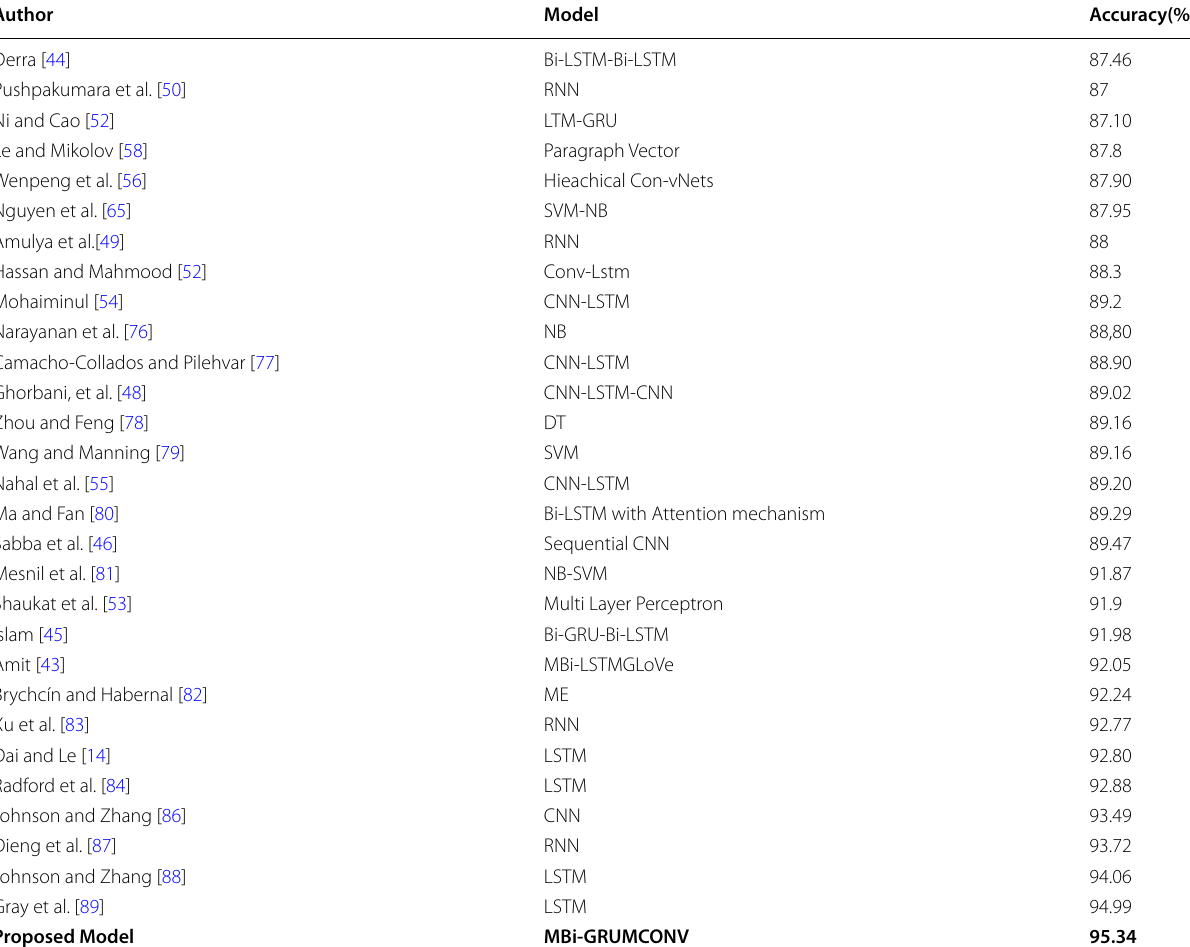
Table 12 Comparison of the test accuracy results of the proposed model with those of previous